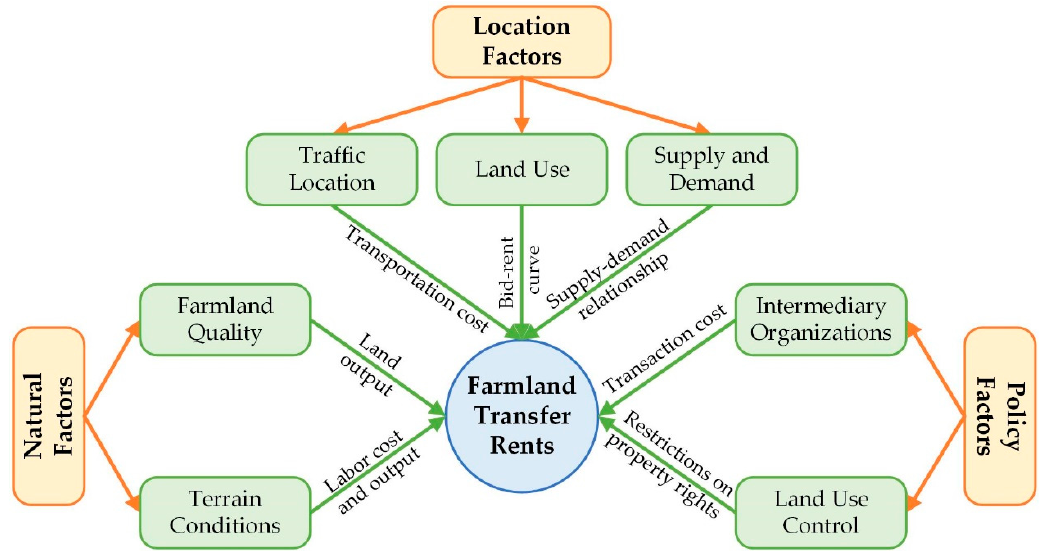
Figure 1. Theoretical framework of factors affecting farmland transfer rents.